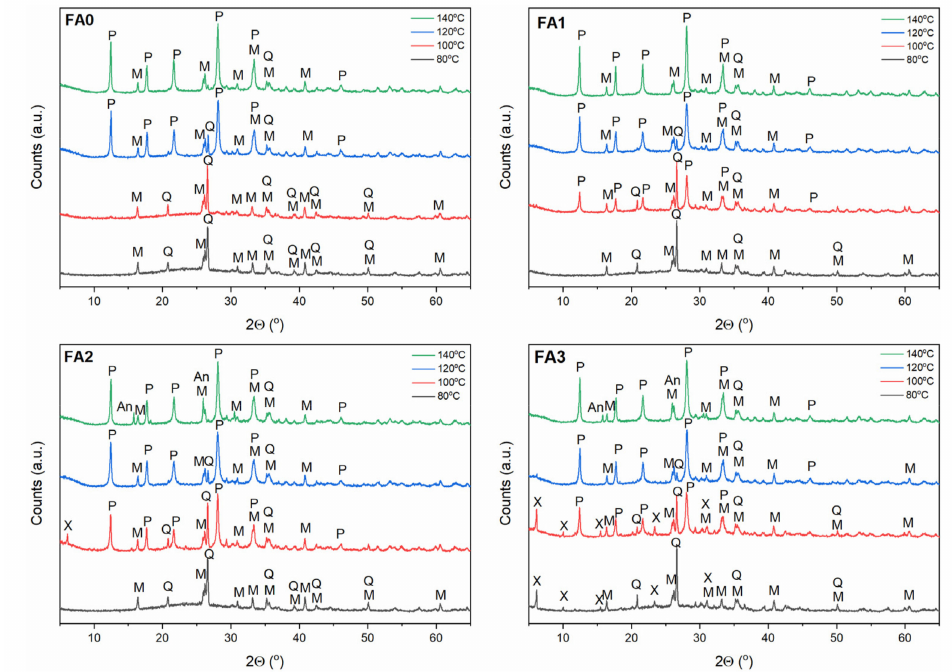
Figure 5. The effect of FA milling and temperature on FA conversion of into Na-P1 zeolite phase. Clarifications: X—zeolite Na-X, M—mullite, Q—quartz, An—analcime, P—zeolite